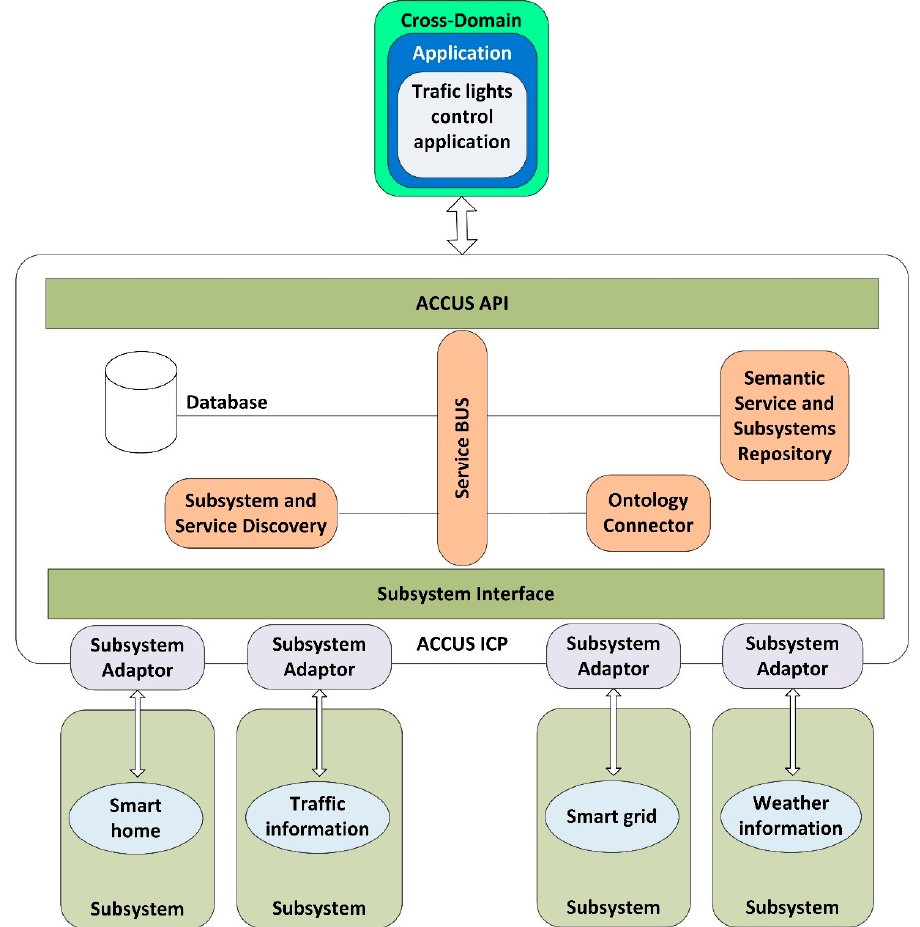
Figure 1. Registration and discovery of subsystems and services in ACCUS.